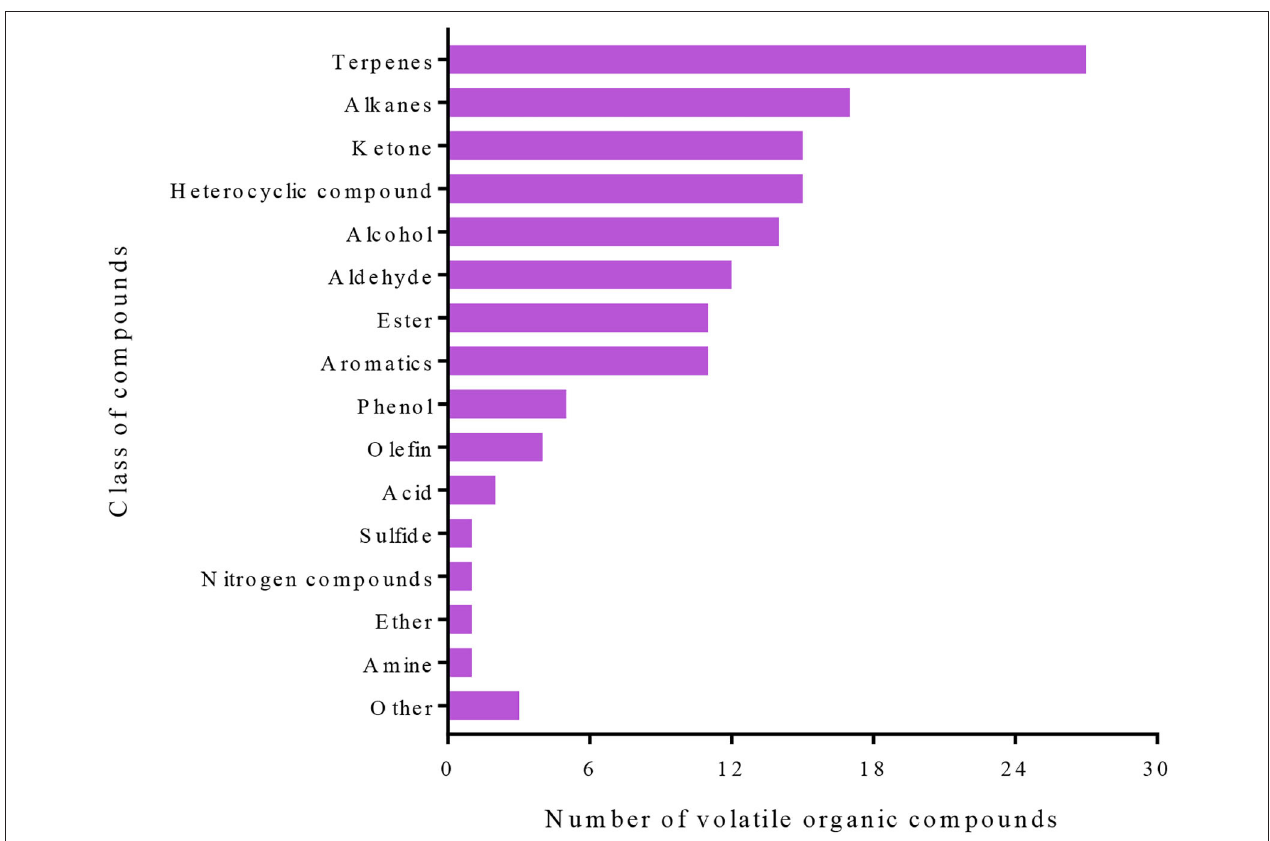
FIGURE 2 | Classes of volatile organic compounds identified in the control and infested leaves of tomatoes and eggplants.